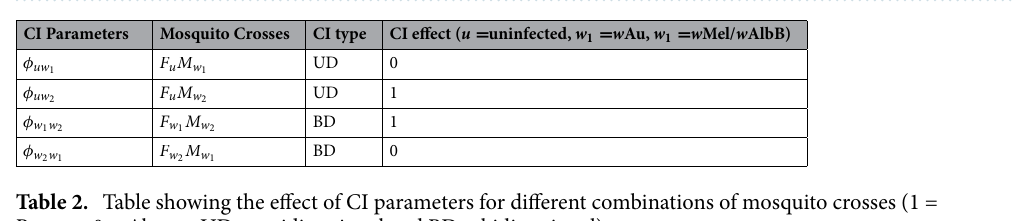
Table 2. Table showing the effect of CI parameters for different combinations of mosquito crosses (1 = Present, 0 = Absent; UD = unidirectional and BD = bidirectional).